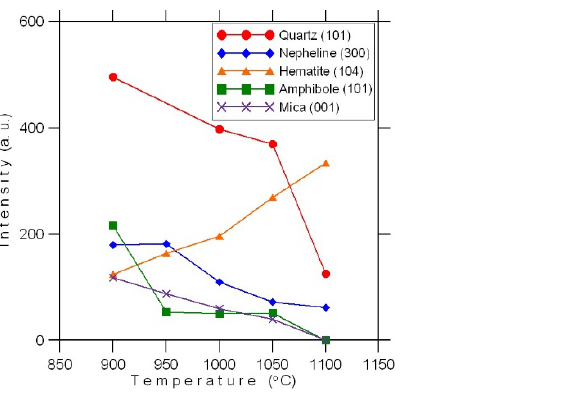
Figure 1. XRD patterns of a ceramic sample fired at different temperatures. The Miller indices (hkl) are indicated for peaks used for the graph in Figure 2.